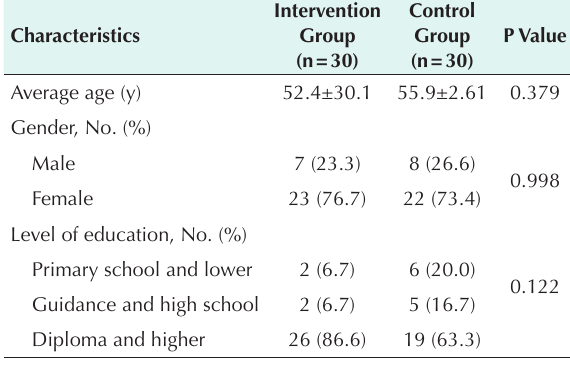
Table 1. Comparison of Underlying Characteristics Between Intervention and Control Groups